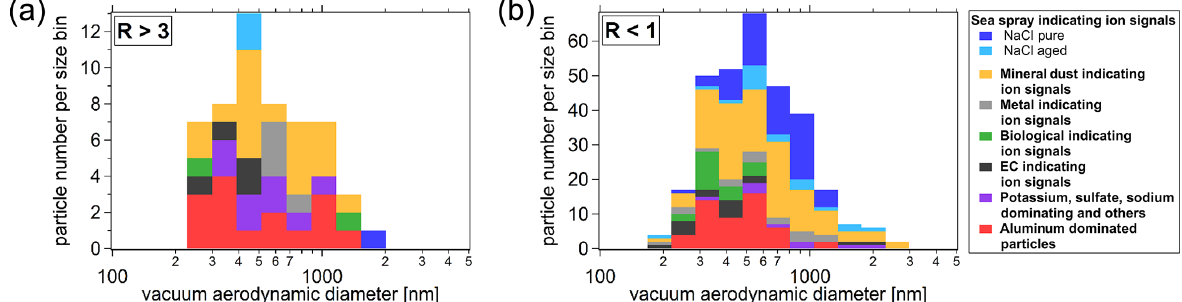
Figure 8. Size-resolved particle number fraction of the determined IPR types for cloud periods with lower ( R > 3; a) and higher ( R < 1; b) proportions of small IPRs ( < 300nm), which is interpreted as lower and higher contribution of secondary ice, respectively (see description in Sect.